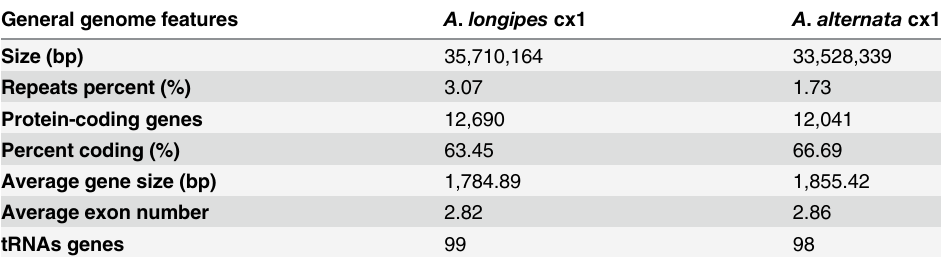
Table 2. A . longipes cx1 and A . alternata cx2 genome features.